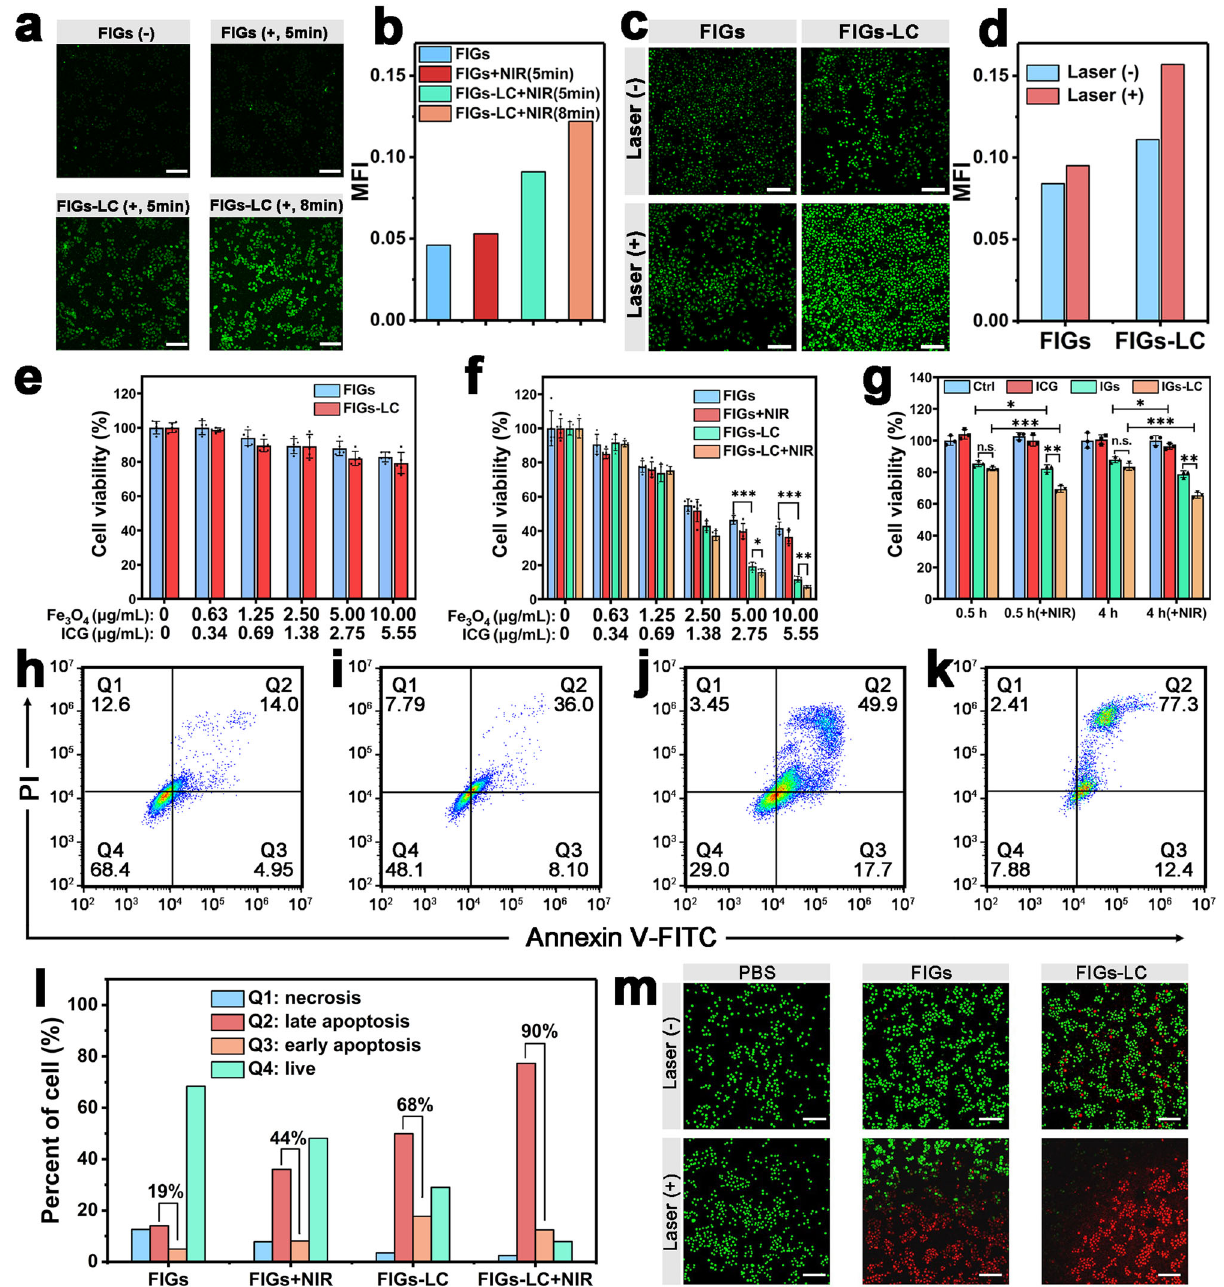
Fig. 5 Intracellular characterization for synergistic CDT and PDT. a Confocal laser scanning microscopy (CLSM) images and corresponding mean fl uorescence intensity ( b ) of human hepatocarcinoma cells (SMMC-7721) cells after co-incubation with FIGs or FIGs-LC for 6 h and treated with SOSG probe, “ − ” represents without laser irradiation and “ + ” represents with laser irradiation, scale bar: 200 μ m. c CLSM images and corresponding mean fl uorescence intensity ( d ) of SMMC-7721 cells treated with FIGs, and FIGs-LC for 12 h with DCFH-DA as a ROS detector, scale bar: 200 μ m. e Cell viabilities of NIH-3T3 cells after incubation with FIGs or FIGs-LC for 48 h. f Cell viabilities of SMMC-7721 cells after incubation with FIGs or FIGs-LC for 48 h with or without NIR irradiation (NIR: 808 nm, 0.25 W, 5 min). g Cell viabilities of SMMC-7721 cells under hypoxic condition after incubation with ICG, IGs, or IGs- LC, the NIR irradiation was carried out after 0.5 or 4 h co-incubation (NIR: 808 nm, 0.25 W). In e – g , data are presented as mean ± s.d. from fi ve ( e , f ) or three ( g ) independent replicates, p values were analyzed by Student ’ s two-sided t -test (* p < 0.05, ** p < 0.01, *** p < 0.001, n.s. represents no signi fi cant differences). h – k Cell apoptosis of SMMC-7721 cells with FIGs, FIGs + NIR, FIGs-LC, and FIGs-LC + NIR incubation was determined by Annexin V-FITC/PI staining. l Quantitation of the cell apoptosis of SMMC-7721 cells under different treatments; the percent represents Q2 + Q3. m CLSM images of live/dead staining of SMMC-7721 cells after incubation with PBS, FIGs, FIGs-LC for 12 h with or without laser irradiation, live cells were stained with Calcein-AM and dead cells were stained with PI, scale bar: 200 μ